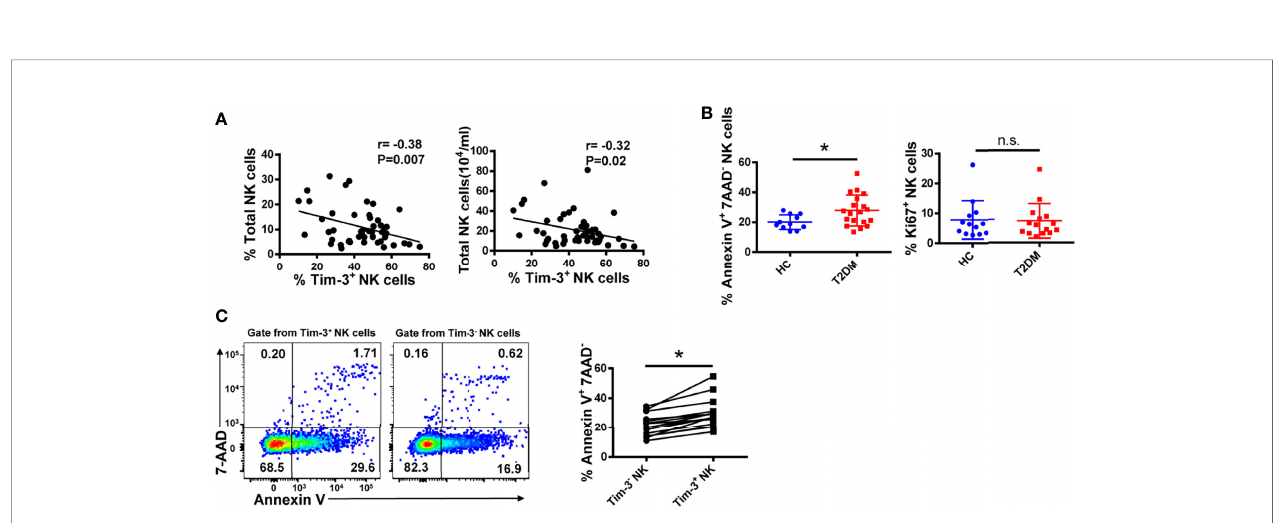
FIGURE 5 | Tim-3 expression is associated with apoptosis of peripheral blood NK cells in T2DM. (A) Correlation analysis of Tim-3 + NK cells and percentage and absolute number of total NK cells in PBMC samples from patients with T2DM (Spearman ’ s correlation test). (B) Comparison of the early apoptosis (Annexin V + 7- AAD - ) and proliferation (Ki67 + ) of NK cells from T2DM patients and healthy controls (HC). Flow cytometry staining for Annexin V (C) of Tim-3 + versus Tim-3 - NK cells in T2DM PBMC samples. Quanti fi cation data for each test sample are shown in the right panel. *P < 0.05. n.s., not signi fi